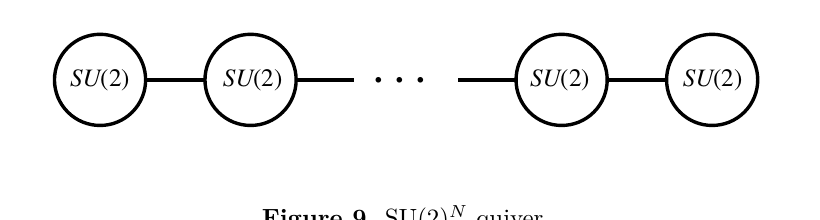
Figure 8 . The X 1 ,N brane web in the SU(2) N limit.